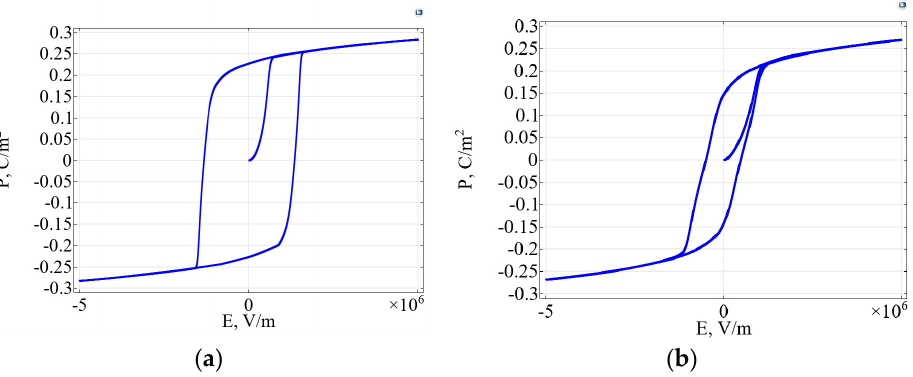
Figure 3. The polarization–electric field dependences under variation of thickness of the film: ( a ) l = 50 nm, ( b ) l = 20 nm.